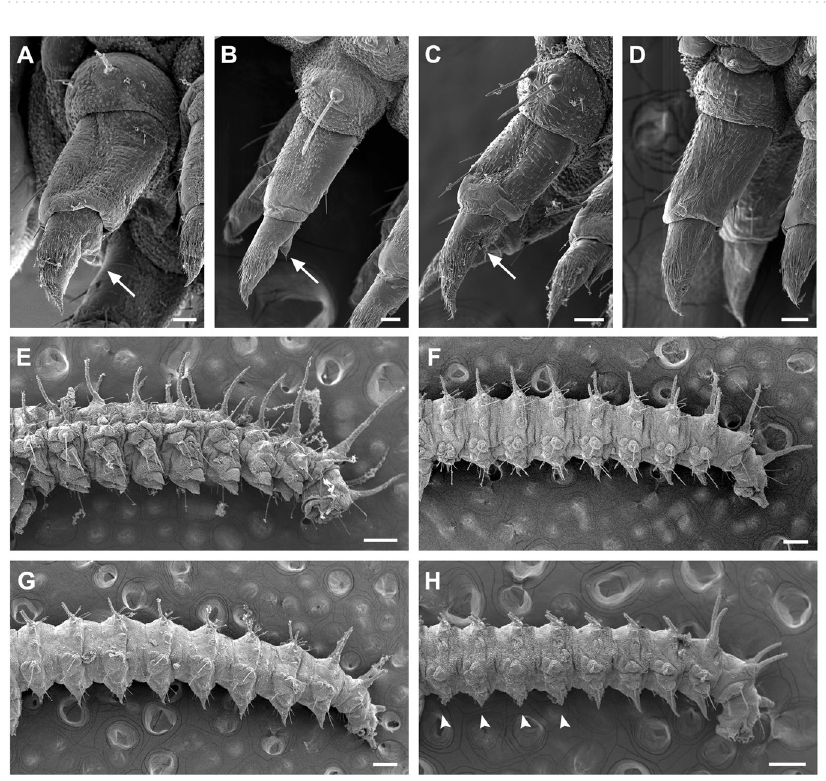
Figure 3. Larval thoracic legs and prolegs of Panorpidae. ( A ) and ( E ) Dicerapanorpa magna ; ( B ) and ( F ) Cerapanorpa nanwutaina ; ( C ) and ( G ) Panorpa curva ; ( D ) and ( H ) Neopanorpa lipingensis ; ( A – D ) prothoracic legs, arrows point to tibial lobes; ( E–H ) prolegs, arrow heads point to morphologically reduced prolegs on the anterior four abdominal segments. Scale bars: ( A – D ) = 40 μ m; ( E )–( H ) = 200 μ